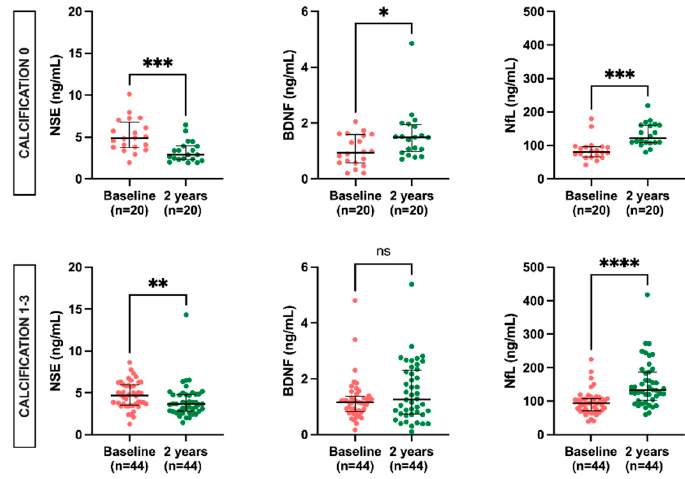
Figure 3. Levels of NSE, BDNF, and NfL at baseline vs. 2 years post-KT according to calcification scores. Results are presented as median and IQR. Differences between baseline and two years post-KT were analyzed using the Wilcoxon paired test. * p < 0.05, ** p < 0.01, *** p < 0.001, **** p < 0.0001.